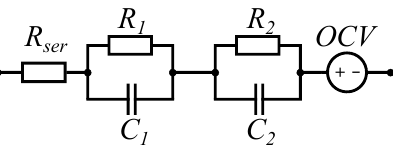
Figure 2. Equivalent circuit diagram of battery